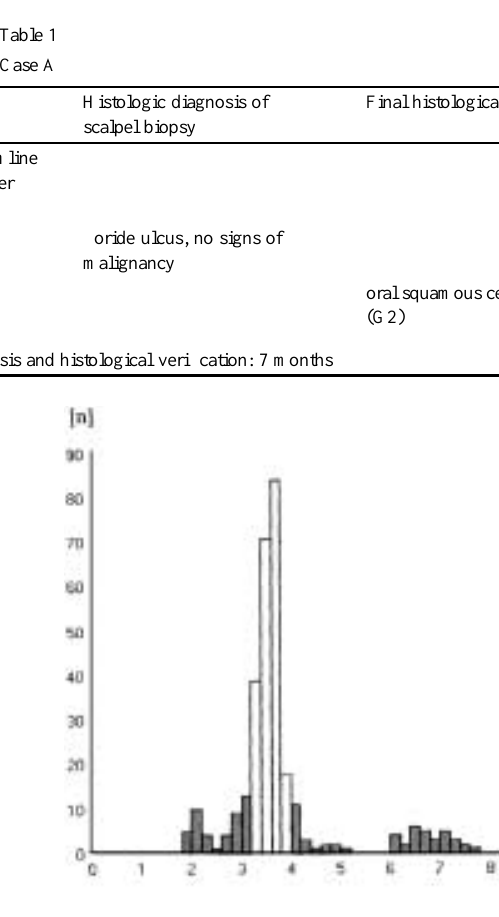
Fig. 5. DNA-histogram of a smear from a squamous cell carcinoma of the alveolar ridge from patient B. One aspect of DNA-aneuploidy can be detected: abnormal stemlines at 3.6c and